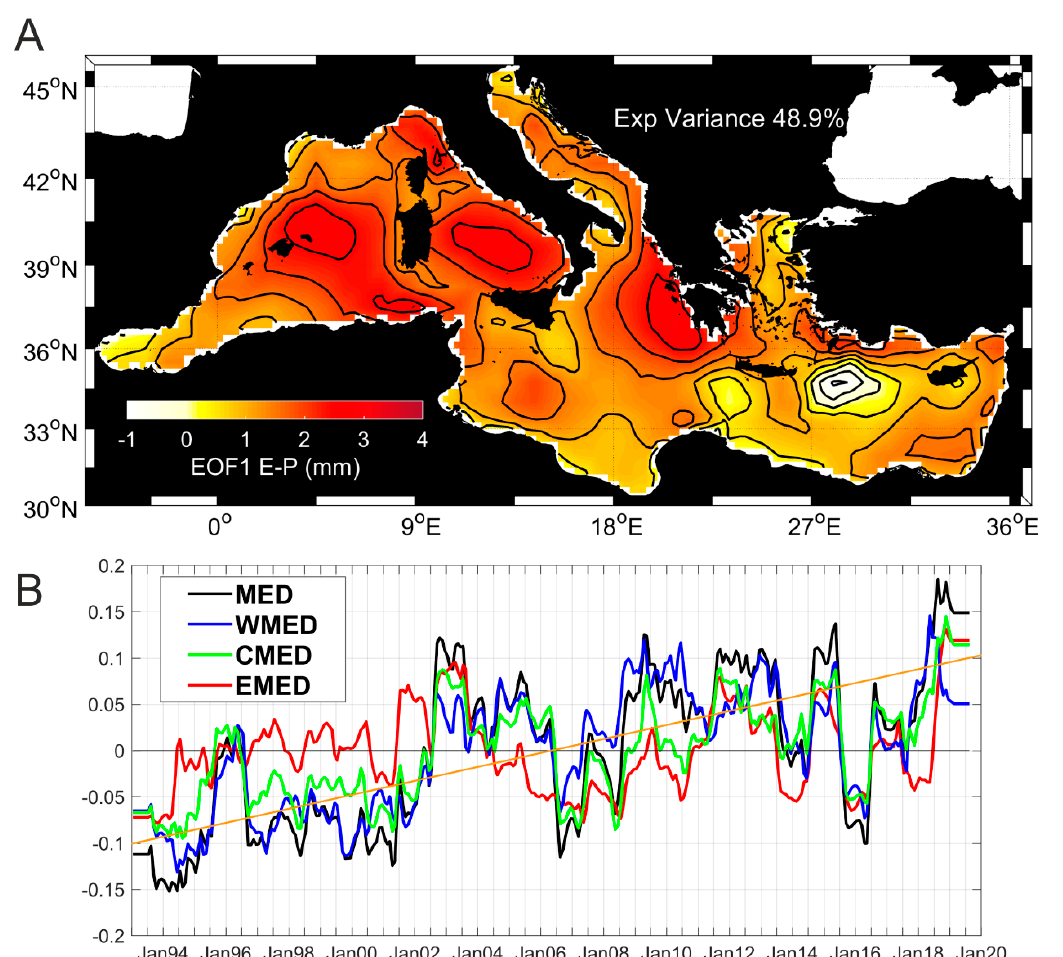
Figure 5. EOF1 ( A ) and PC1s ( B ) of the E-P. The PC1s ( B ) are estimated for the whole Mediterranean (MED, black line) and for the three main sub-basins separately (West Mediterranean—WMED, blue line; Central Mediterranean—CMED, green line; Eastern Mediterranean—EMED, red line). The long-term linear trend (orange line) is estimated on the PC1 of MED.